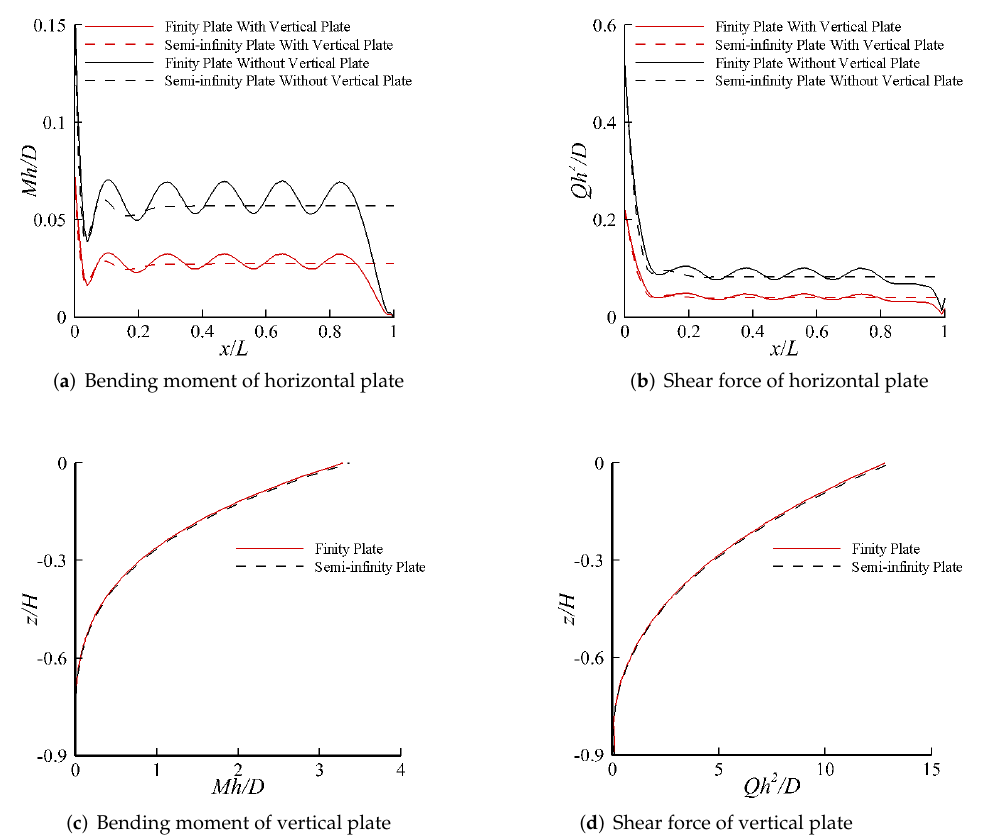
Figure 8. Bending moment and shear force of the vertical and the horizonal plate.